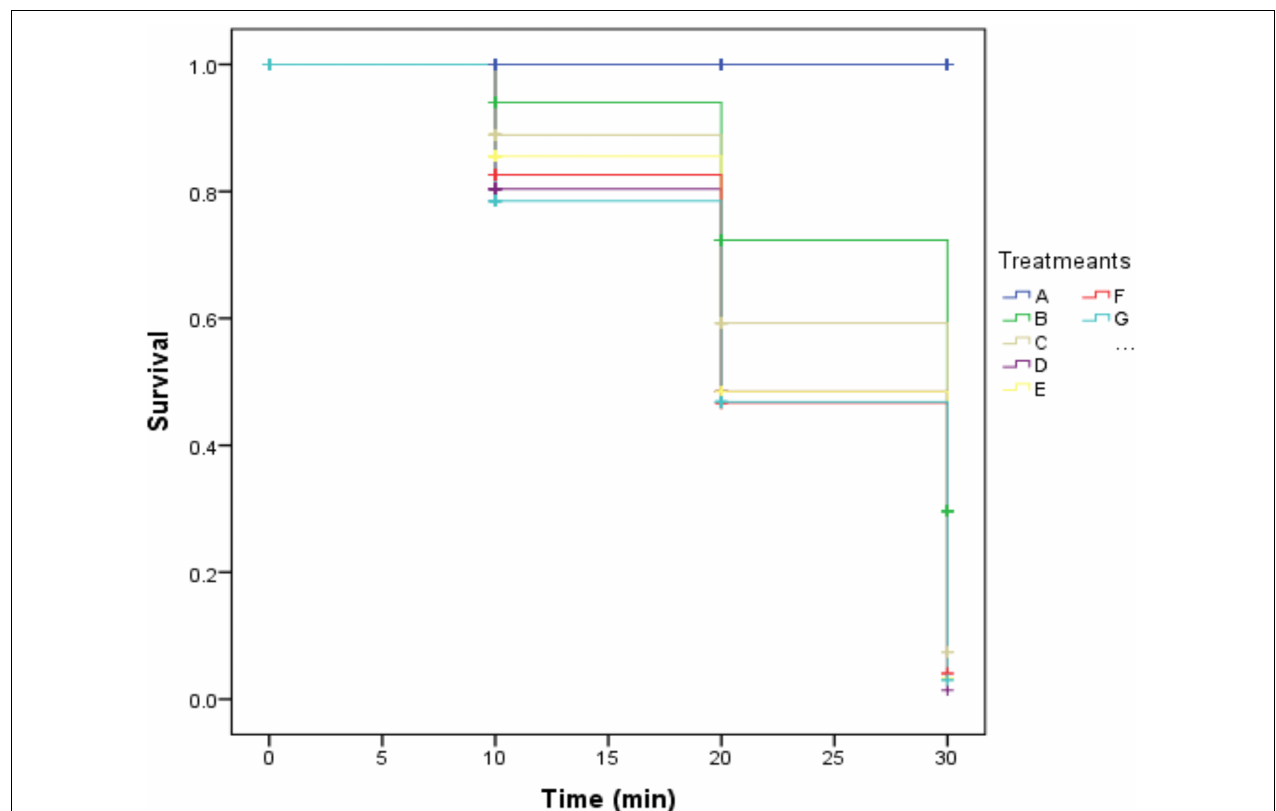
FIGURE 1 | Kaplan-Meier survival curve after exposure to the pyrethroid insecticides permethrin and deltamethrin in an adult population of Aedes aegypti using the CDC bottle bioassay ( p ≤ 0.05). A: fed with sucrose 10%, B: exposed to permethrin. (control group), C: treated with penicillin/streptomycin permethrin exposed, D: treated with gentamicin permethrin exposed, E: exposed to deltamethrin (control group), F: treated with penicillin/streptomycin deltamethrin exposed, and G: treated with gentamicin deltamethrin